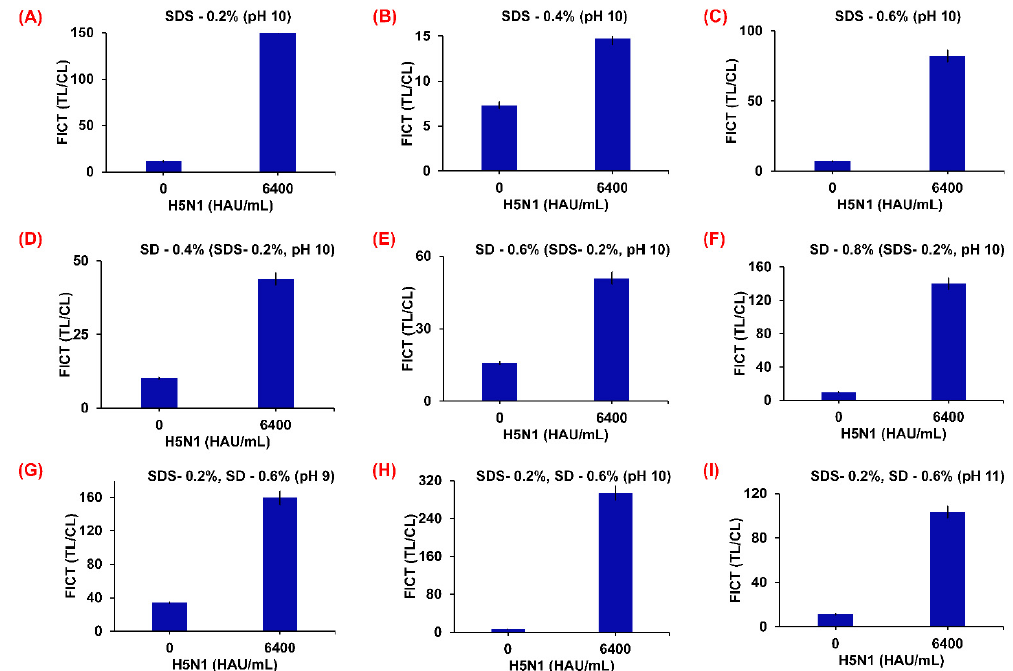
Figure 8. Optimization of lysis buffer for EuNPs-FICT. Various concentrations of SDS (0.2, 0.4, and 0.6%), SD (0.8, 1.0, and 1.2%), and different pH values (9, 10, and 11) (0.1 M Tris, 0.1 M EDTA, and 1% Triton X-100) were tested in basic lysis buffer. Buffer was dissolved at three different SDS concentrations ( A – C ); 0.2% SDS was dissolved in lysis buffers of different SD concentrations ( D – F ) at pH 10; 0.2% SDS, and 1.2% SD were dissolved in lysis buffers at different pH ( G – I ). 2.4. Performance of Cys Au-Eu NPs Conjugates in RDT and FICT Kits